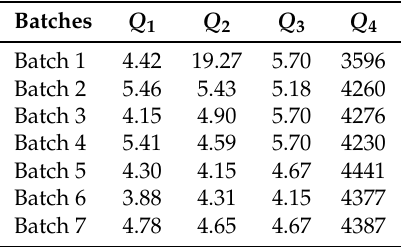
Table 1. Quality measurements for training batches.